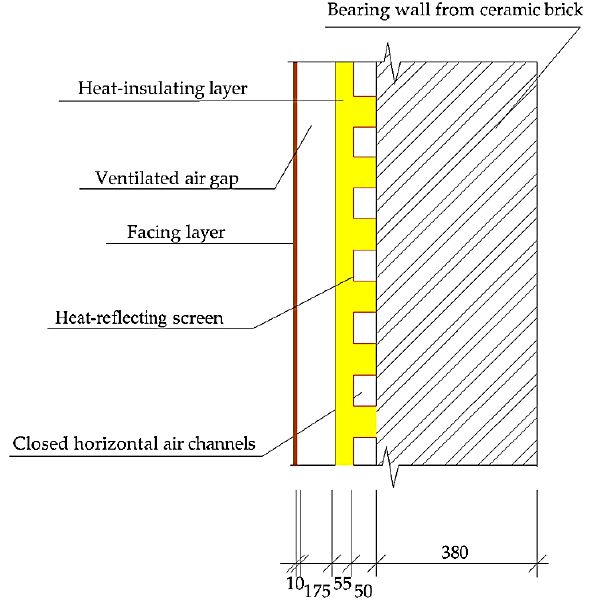
Figure 6. multilayer wall enclosing structure with a homogeneous bearing layer and a heat-insulating plate layer with horizontal air channels and a heat-reflecting screen heat-reflecting screen — aluminum foil (the thickness of the layers of the structure is given in millimeters). Table 1. Characteristics of the enclosing structure layers according to Figure 1 [36]. Table 4. Climatic and internal boundary conditions